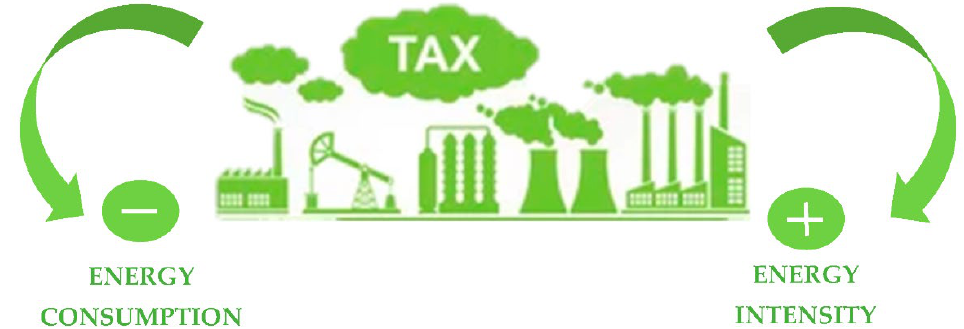
Figure 5. Graphical results of the